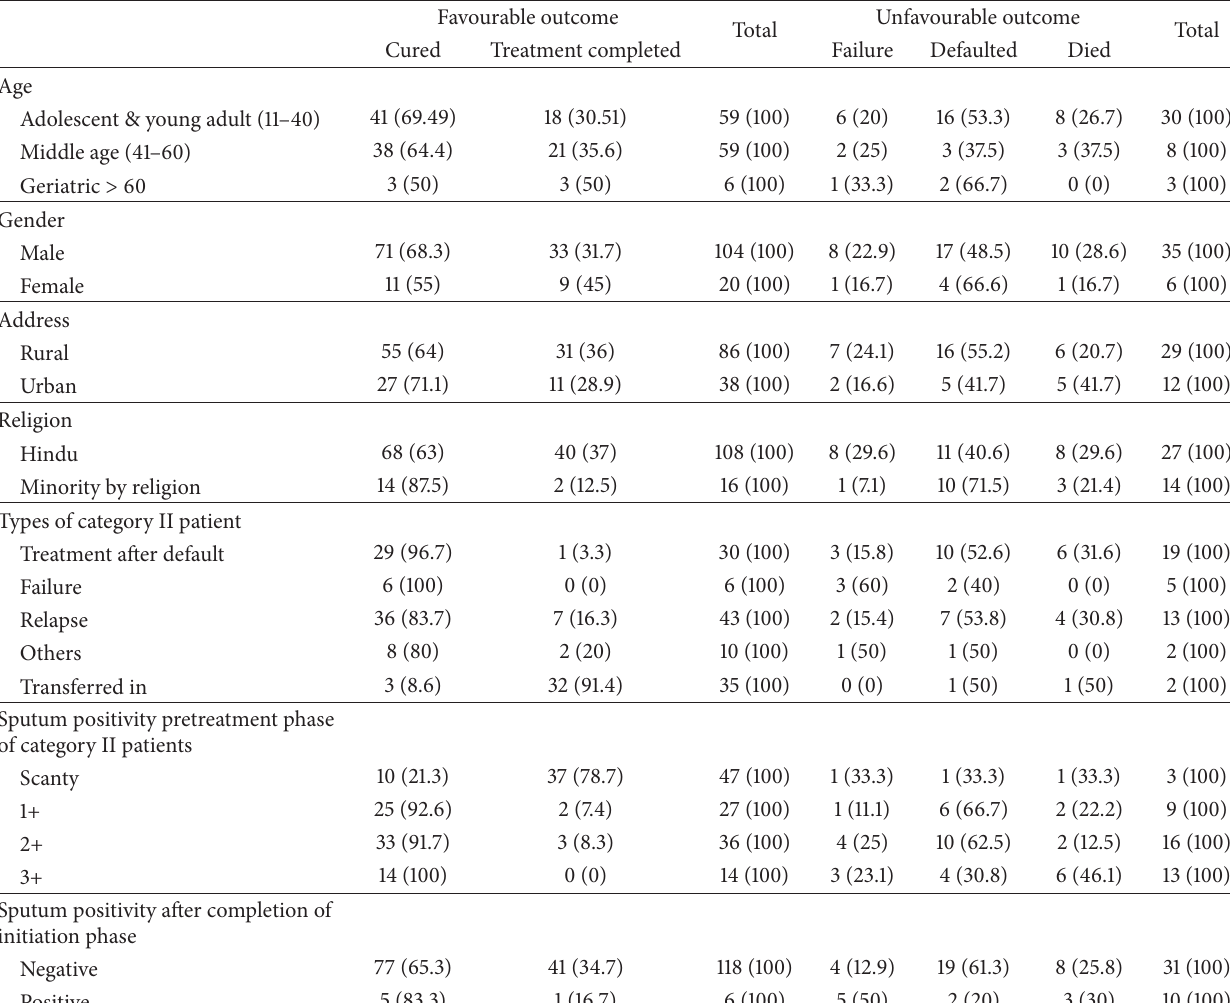
Table 2: Distribution of tribal patients according to the patient’s profile and treatment outcome. 𝑁 = 165 . Favourable outcome Unfavourable Total